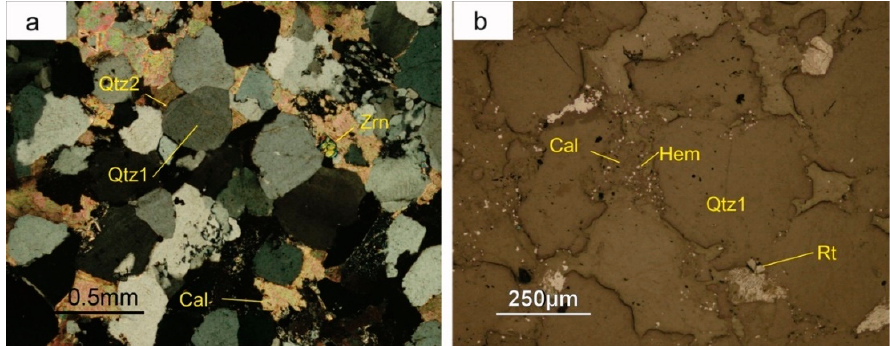
Figure 5. Microphotographs of the cements in the red beds. ( a ) Cement sequence in the red beds: dirty detrital quartz (Qtz1) with clean rims of syntaxial quartz cement (Qtz2), followed by sparry calcite cement (Cal). Note a detrital zircon grain (Zrn). Transmitted light, cross-polarized light (XPL); ( b ) Detrital quartz grains in the red beds (Qtz1) cemented by hematite (Hem) and calcite (Cal). Small rutile grains (Rt) are also found in the host rocks. Reflected light, plane-polarized light (PPL). All minerals in this manuscript follow the mineral abbreviation as suggested by IUGS [52].